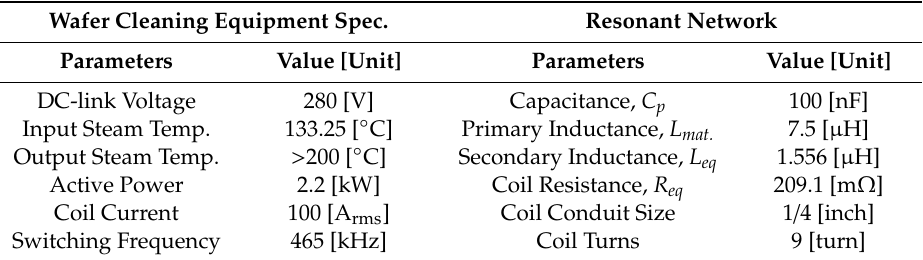
Table 2. Specifications of the cleaning equipment and resonant network parameters. Wafer Cleaning Equipment Spec.